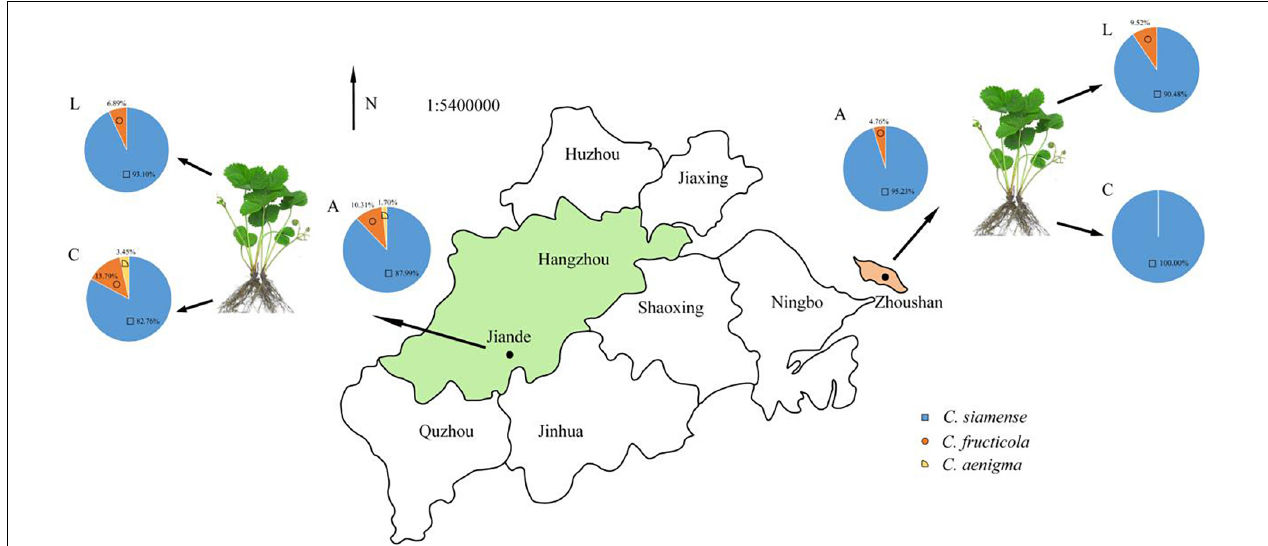
FIGURE 6 | The proportion of Colletotrichum spp. associated with LA and CR in Zhejiang province, China. A, all strains; L, leaf strains; C, crown strains, the scale is 1:54,000,000. TABLE 3 | Size of spore, appressoria, growth rates, sporulation and spore germination rate of Colletotrichum species from leaf and crown of strawberry. Species x Conidia y Appressori Growth Rate (mm/day) y Sporulation ( × 10 6 ) Germination rate (%) y